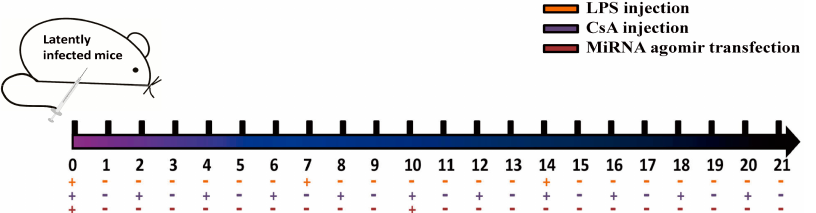
Figure 1. A schematic diagram depicting agomir transfection into mouse livers is shown. Briefly, BALB/c mice with latent murine cytomegalovirus (MCMV) infection were divided equally into three groups (eight per group). All mice were injected intraperitoneally with lipopolysaccharide (LPS; 15 µ g/kg weekly) and cyclosporin A (CsA; 20 mg/kg/d every other day) for three weeks. To overexpress viral microRNAs (miRNAs), the mice received hydrodynamic injections of 2 mL phosphate-buffered saline (PBS) containing miR-m01-3-5p, miR-M23-1-5p, or negative control agomir (NC-agomir) on day 0 and day